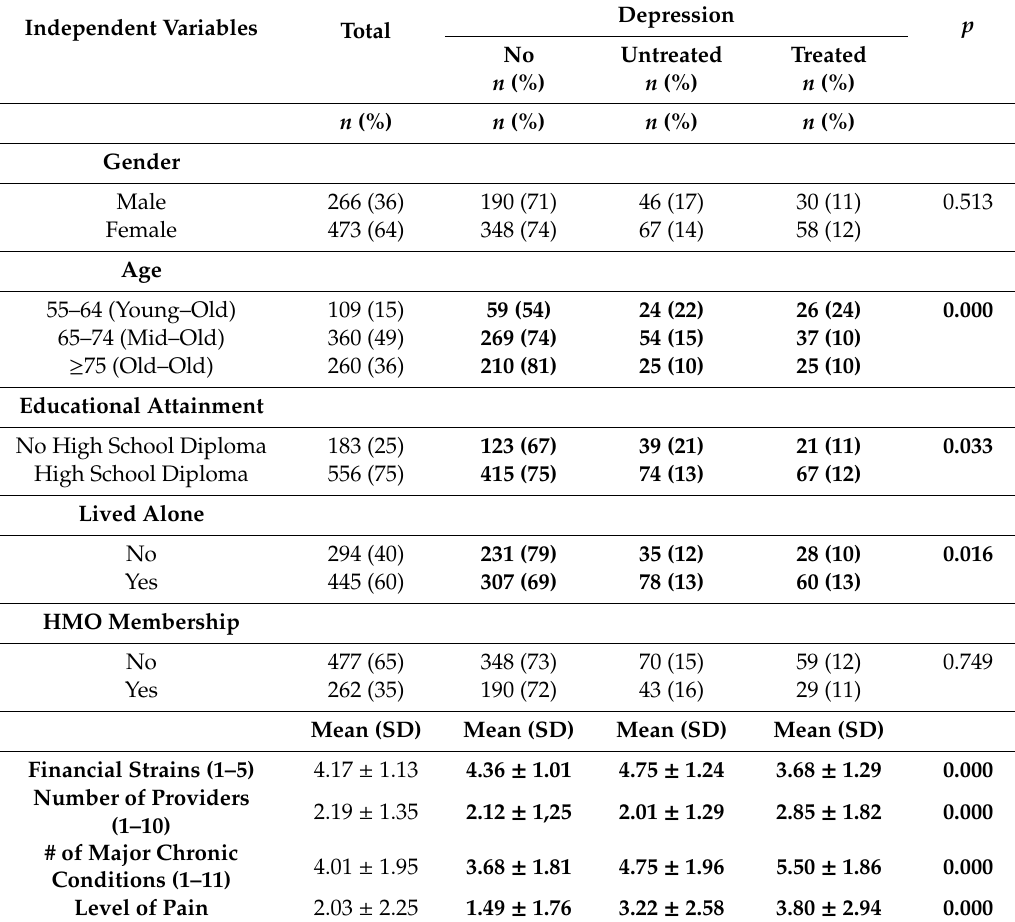
Table 1. Descriptive statistics and bivariate correlations between depression and independent variables ( n =